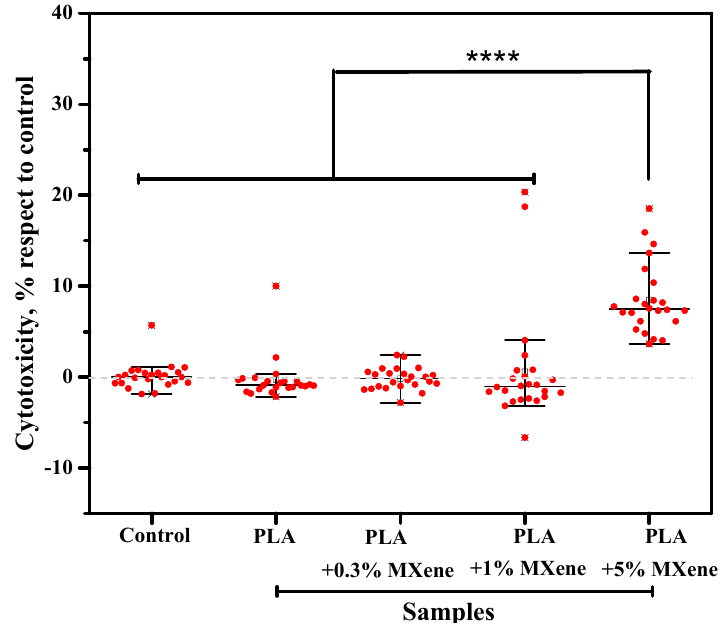
Figure 6. Cytotoxicity of the PLA and composite films with different loads (0.3, 1, 5 wt.%) of MXene particles.